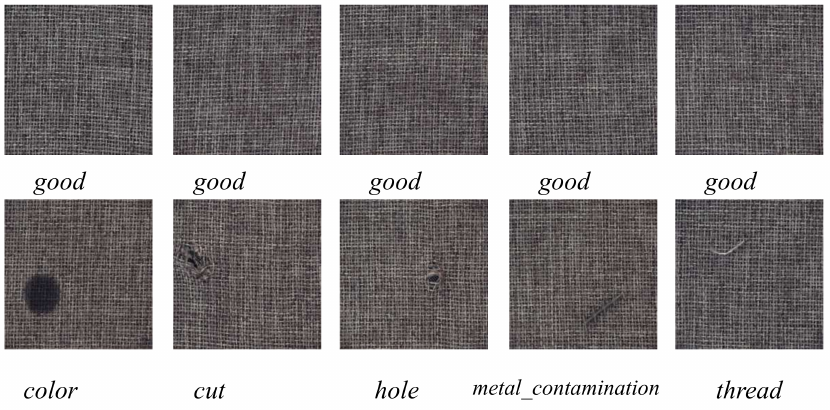
Figure 4. Examples of good and defective images from the carpet